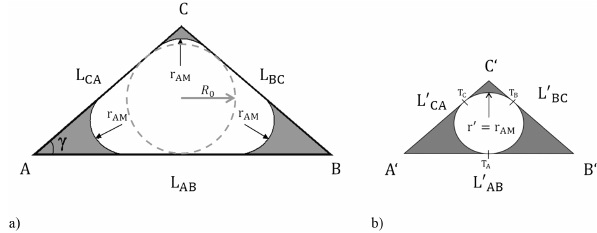
Figure 3. Cross sections of a partially saturated triangular tube. The arc meniscus of radius r AM separates the invading non-wetting phase (white) from the adsorbed wetting phase (gray). (a) Origi- nal triangle ABC with side lengths L AB , L BC , L CA , and radius R 0 of its inscribing circle. (b) Reduced triangle A (cid:48) B (cid:48) C (cid:48) of similar ge- ometry. The wetting phase resides in the three corners (gray) with r (cid:48) = r AM being the radius of both the three interface arc menisci of ABC and of the inscribing circle of A (cid:48) B (cid:48) C (cid:48)